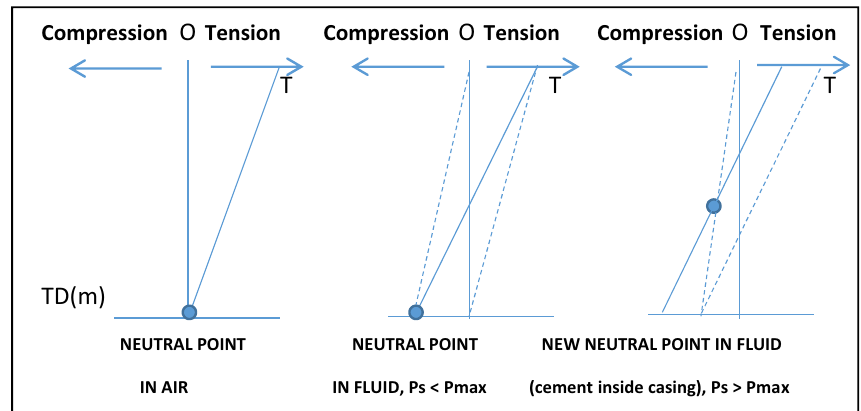
Fig. 10 Neutral pint and buckling force variation under different down hole conditions.